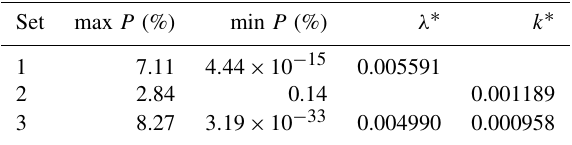
Table 2. RF approach: maximum and minimum probabilities of oc- currence P for the analyzed ensembles and combination of param- eters with maximum P .